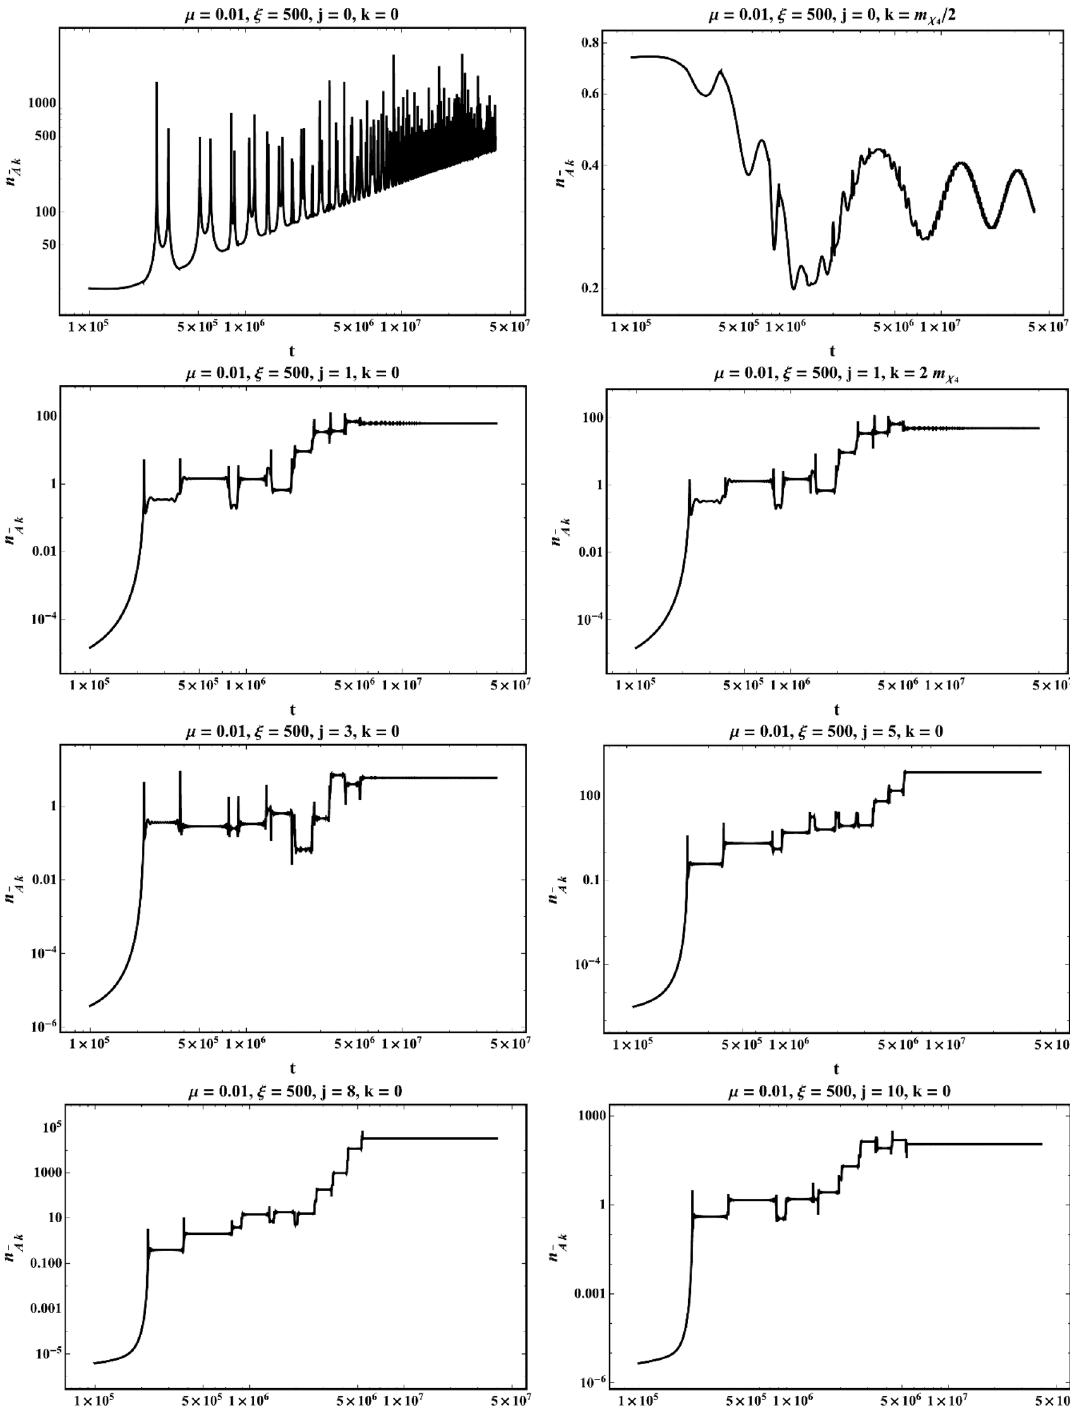
Figure 11 . The time evolution of number density for the gauge preheat modes, n (cid:22) values of j and k for (cid:22) = 0 : 01 M P and (cid:24) = 500.